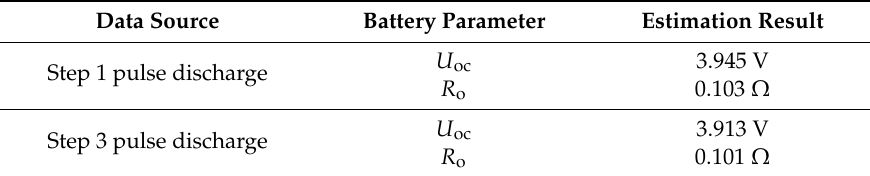
Table 2. The o ffl ine estimation results of battery Table 2. The offline estimation results of battery parameters.